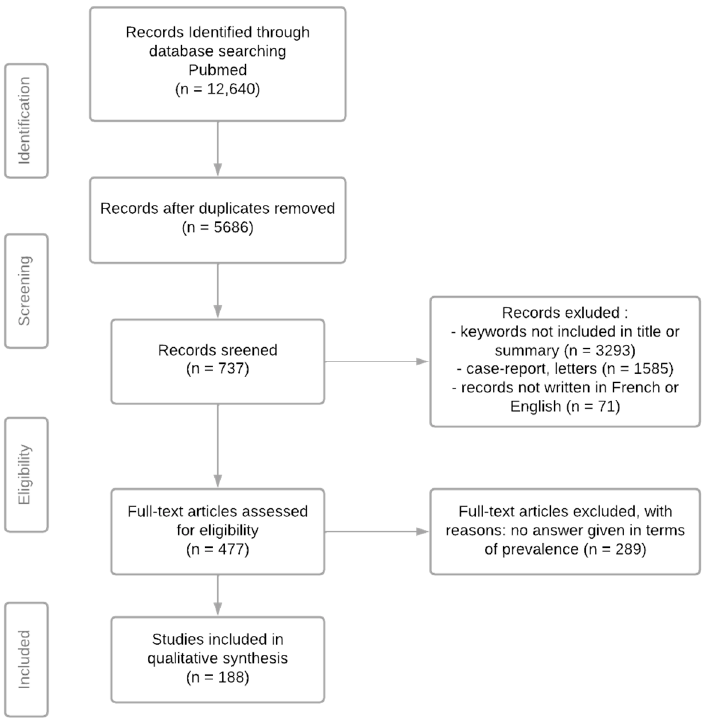
Figure 1. Flow Figure 1. Flow chart.